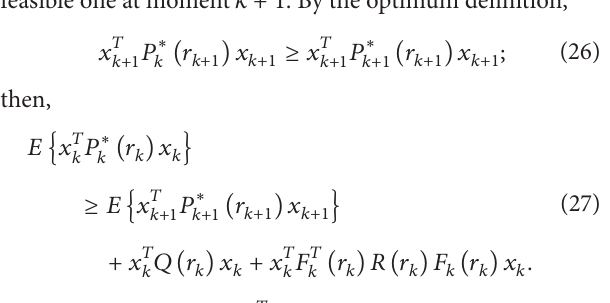
Algorithm 7 robustly stabilizes the closed-loop